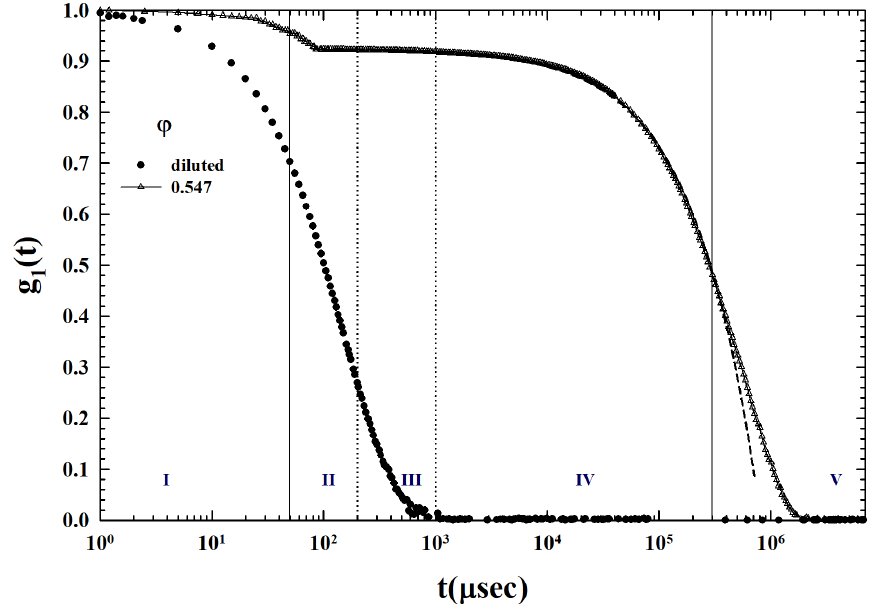
Figure 5. The ISFs for ϕ = 0.547 and the diluted one, together with the different MCT time domains from the microscopic motion (I) to the slow inter-cage (V), and the the β -caging dynamics (II, III and IV). The dashed line is a fit of the von Schweidler’s law scaling